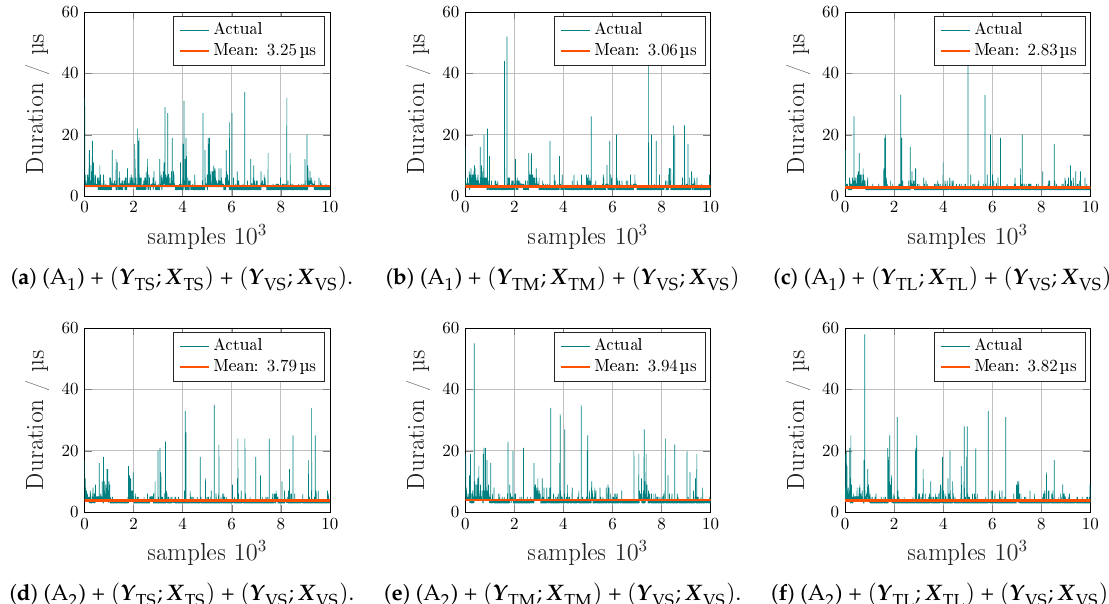
Figure 16. Illustration of execution times over 10.000 samples during the validation of the ANN Architectures (A 1 ) [top row] & (A 2 ) [bottom row] with the small validation data set ( Y VL ; X VL ) (trained each with the small, medium and large ( Y TS ; X TS ) , ( Y TM ; X TM ) and ( Y TL ; X TL )